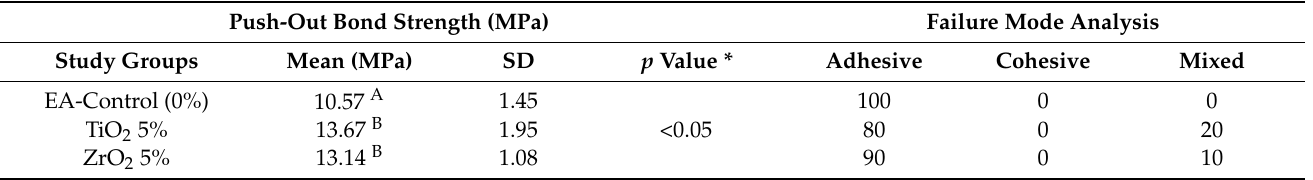
Table 1. Mean and standard deviation of push-out bond strengths of experimental adhesives (MPa). Push-Out Bond Strength (MPa)